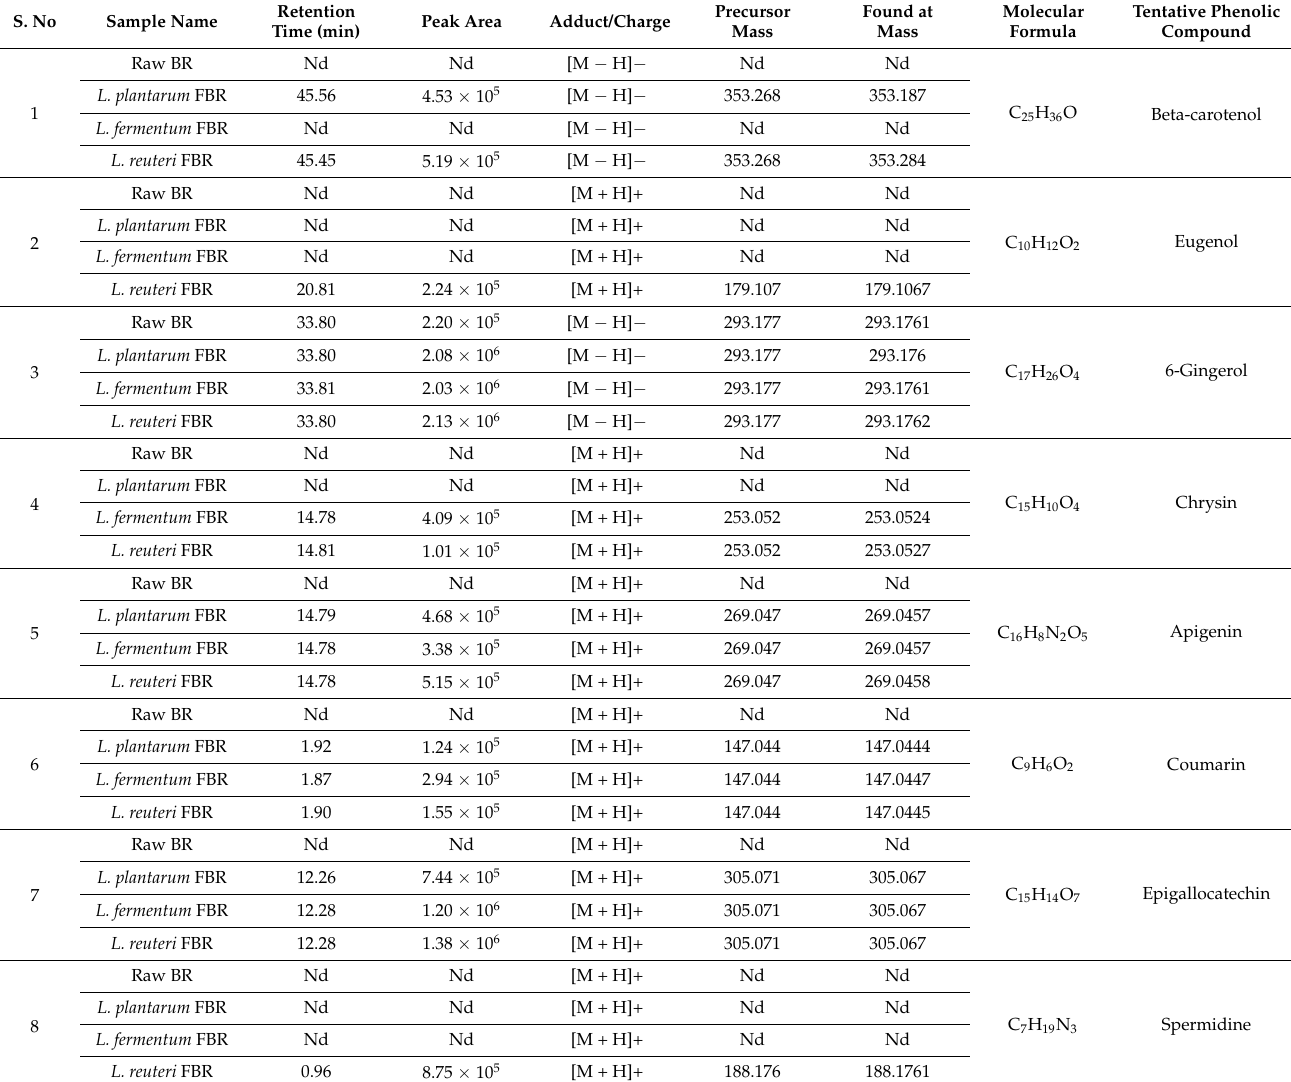
Table 2. Phenolic compounds detected in raw and LABs fermented